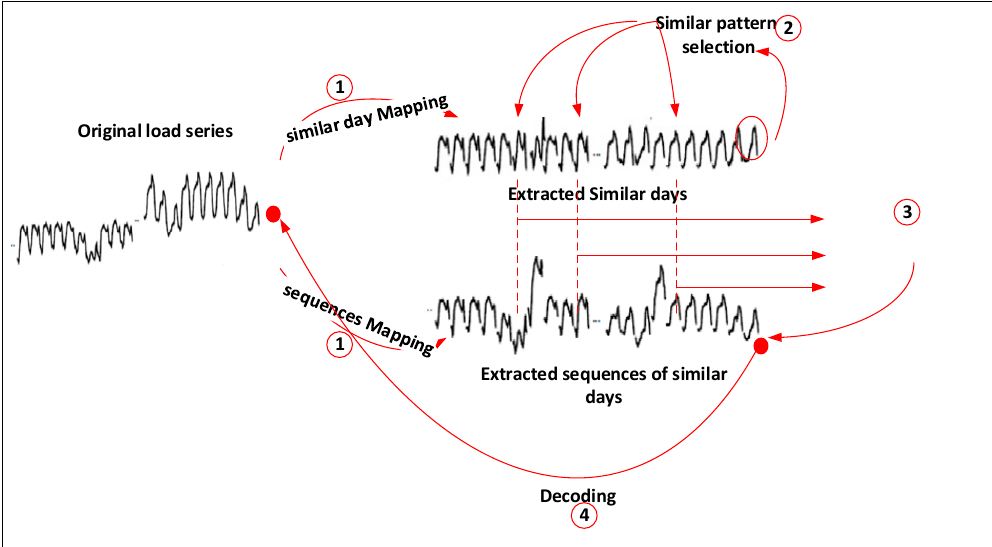
Figure 3. Similar day-based prediction algorithm developed by Dedek et al. [20] .